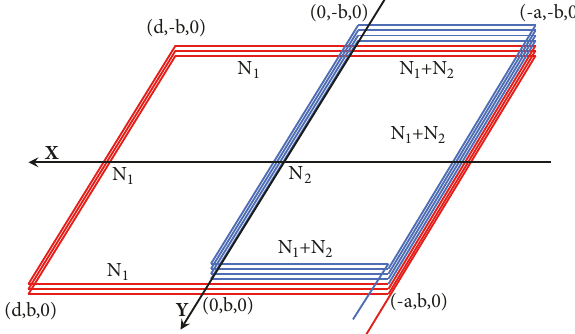
Figure 6: Exposure Level Tester ELT-400.